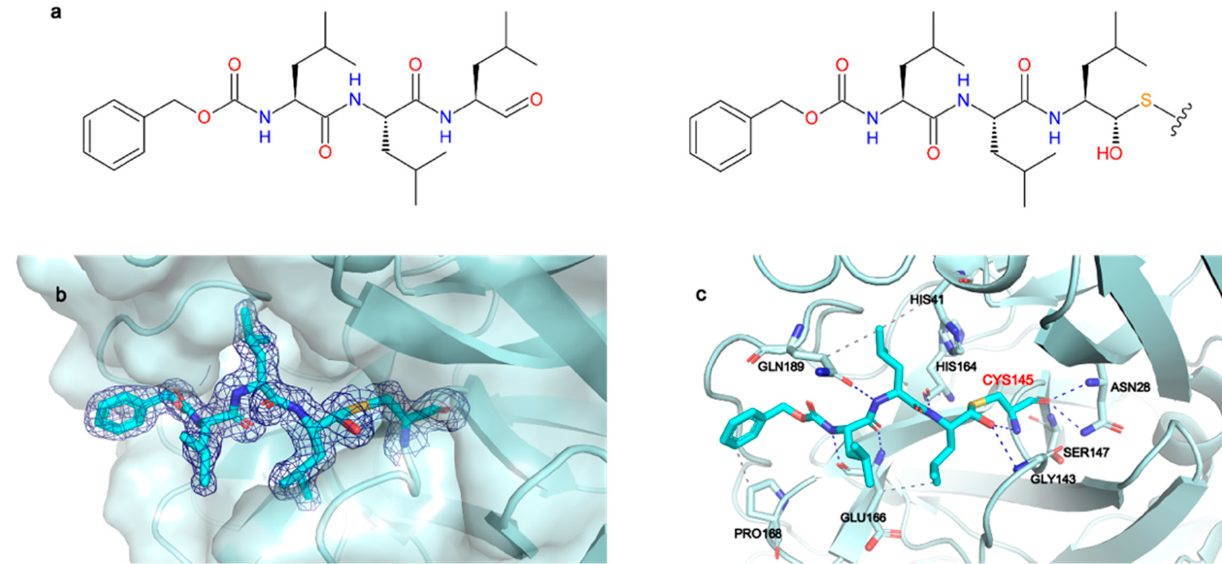
Figure 2. MG-132 is covalently bound to Cys145 in Mpro active site. ( a ) Left panel: chemical structure of MG-132, right panel: chemical structure of MG-132 covalently bound to Cys145. ( b ) X-ray crystal structure of MG-132 covalently bound to Cys145 with 2Fo-Fc map contoured at 1 sigma. ( c ) Main interactions of MG-132 with active site residues. Hydrogen bonds (blue dashed lines), hydrophobic interactions (grey dashed lines).